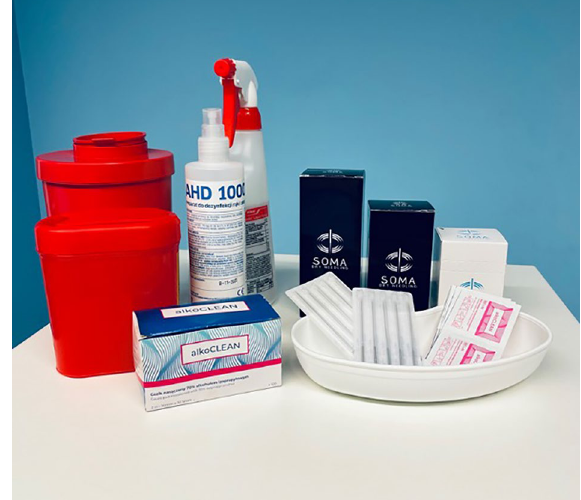
Figure 5. Equipment for DN procedure.